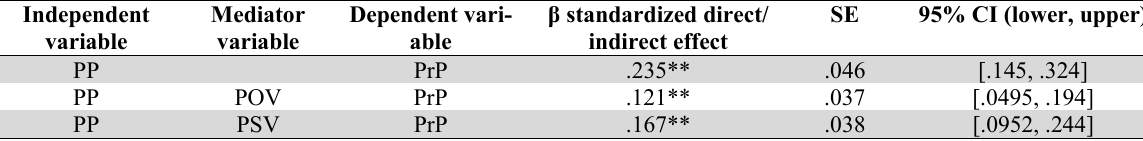
Bootstrap analysis of the magnitude and statistical significance of the direct and indirect effects Independent